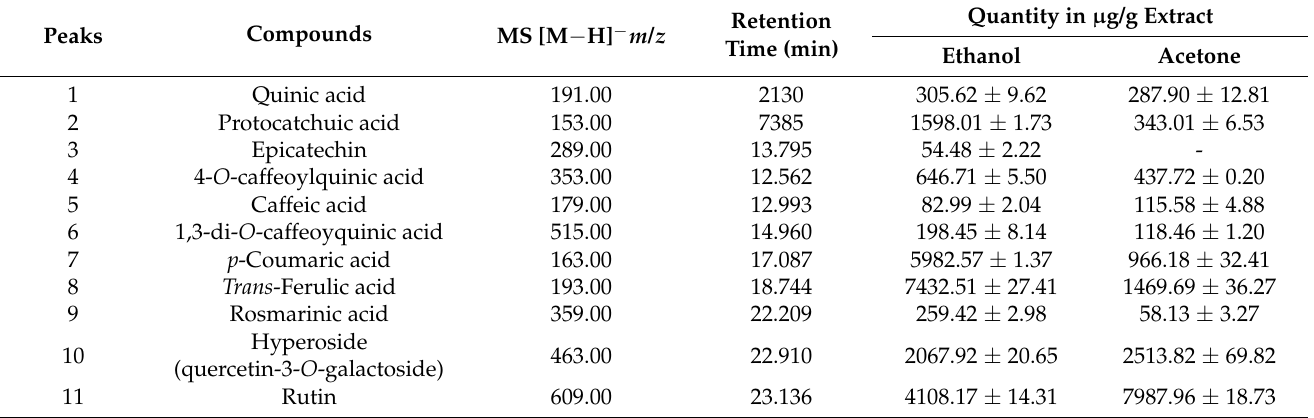
Table 2. Identified by acetone and ethanol extract obtained from A. indicum